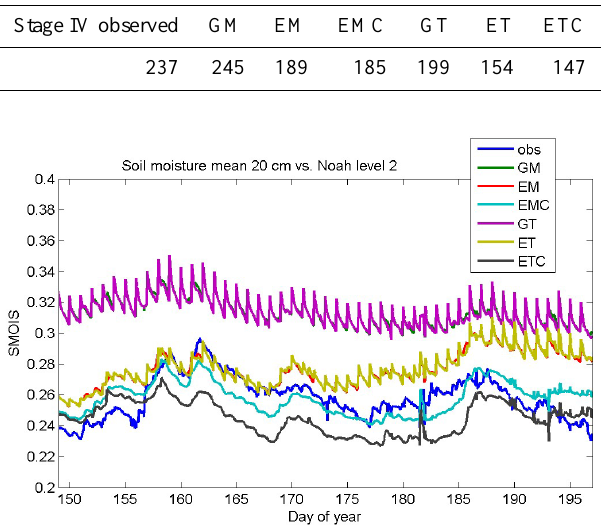
Table 4. Mean precipitation totals (mm) in the portion of the domain shown in Figs. 4 and 5.